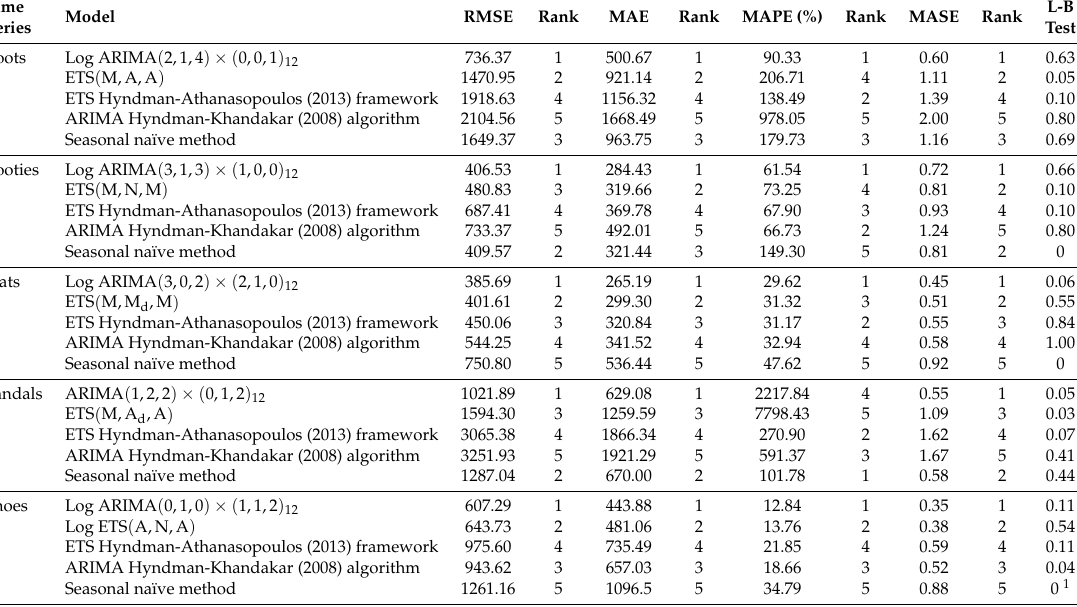
Table 1. Forecast accuracy measures of all forecasting approaches computed using time series